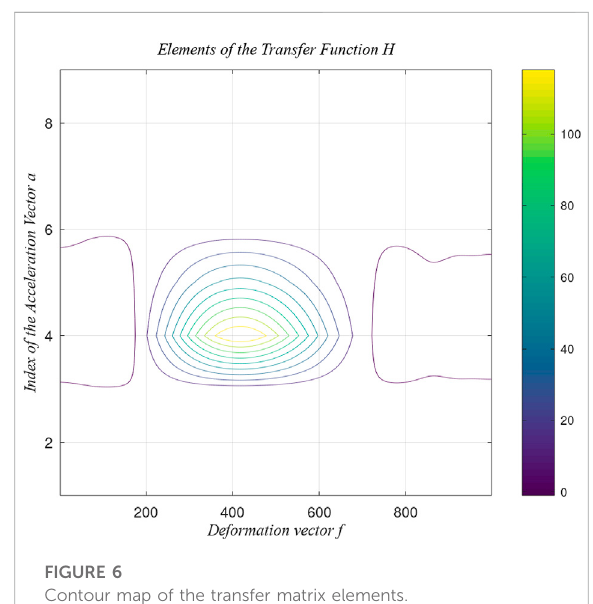
FIGURE 6 Contour map of the transfer matrix elements.